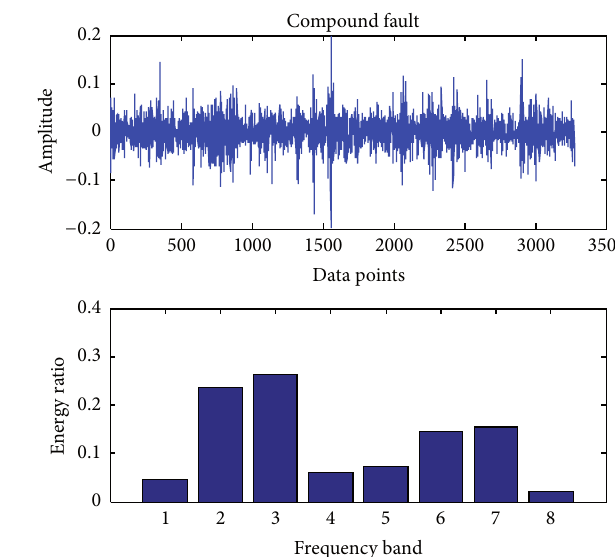
Figure 6: Inner race fault.